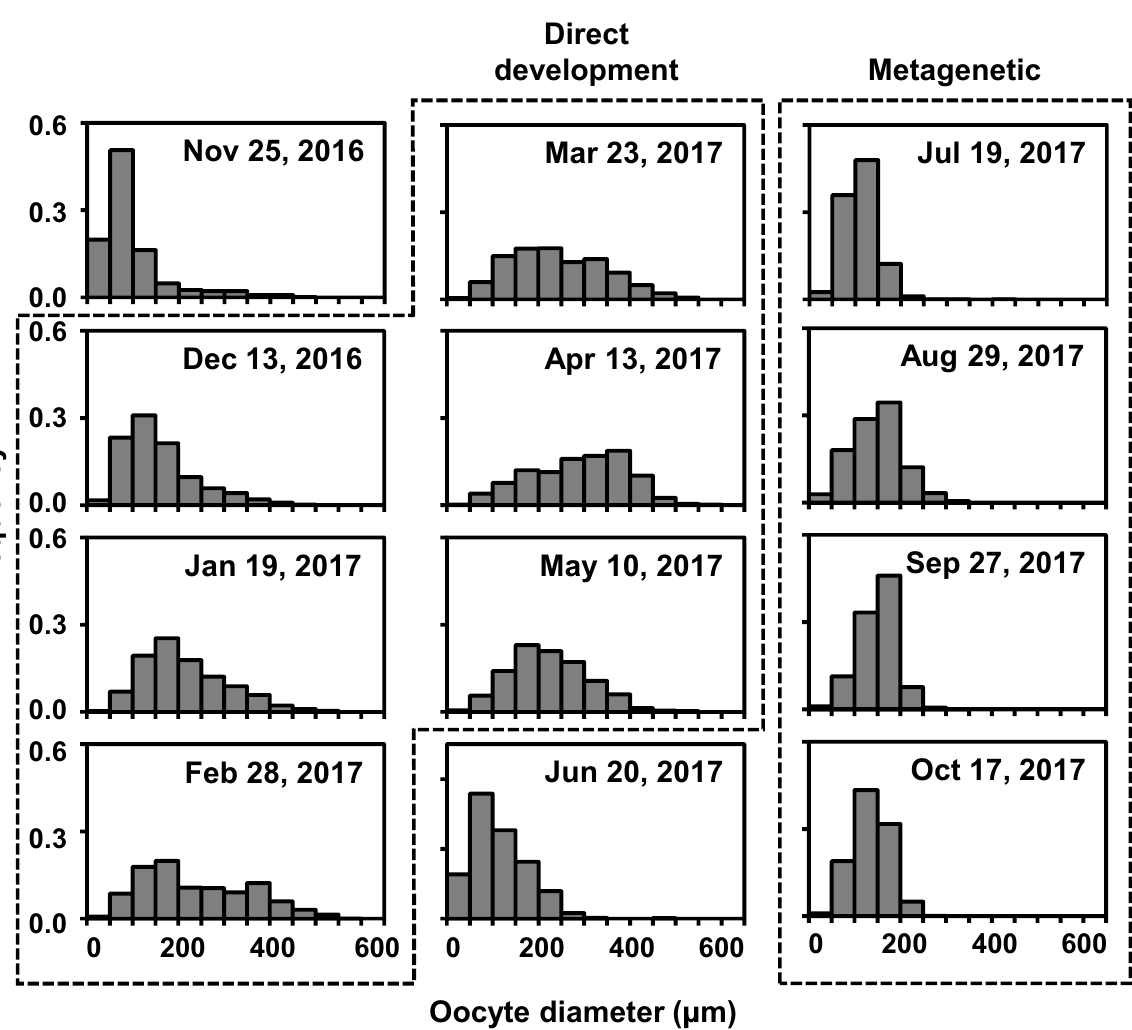
Fig 8. Seasonal change in oocyte diameter. Two boxes with dashed lines indicate the direct-development and metagenetic periods.